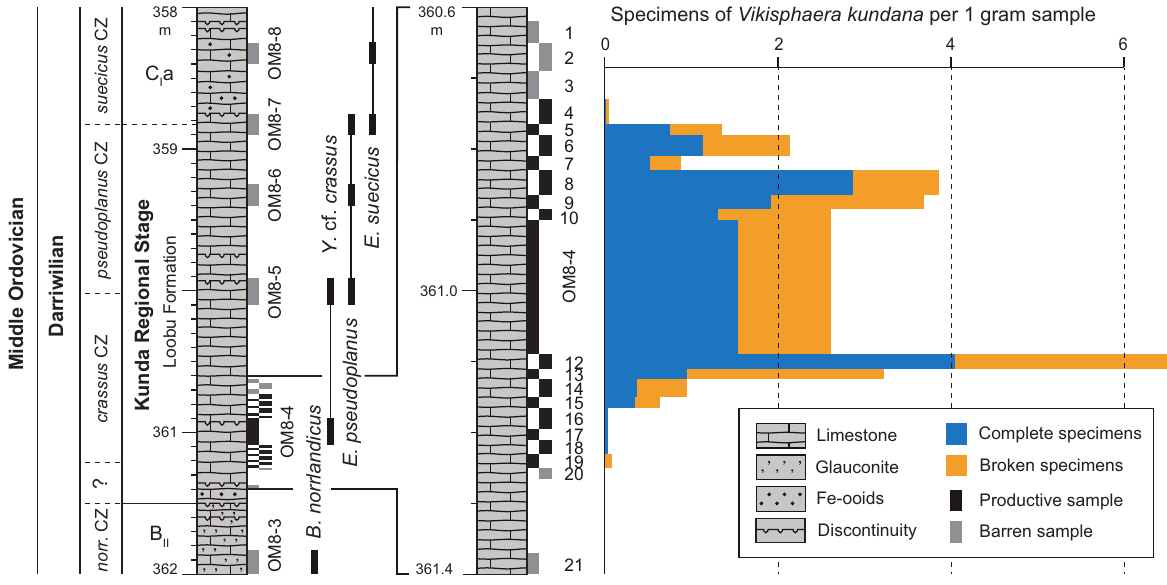
Fig. 6. Range of Vikisphaera kundana in the type locality, Viki drill core, western Estonia. Stratigraphy of the core according to Hints et al. (2014) and Põldvere (2010). Abbreviations: CZ, conodont zone; norr ., norrlandicus ; B II , Volkhov Regional Stage; C I a, Aseri Regional